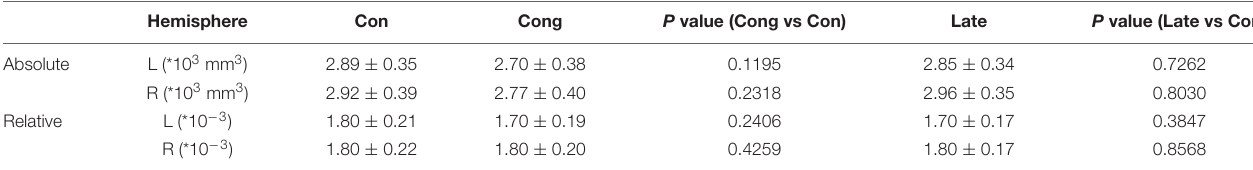
TABLE 2 | Volume information of the current cohort.